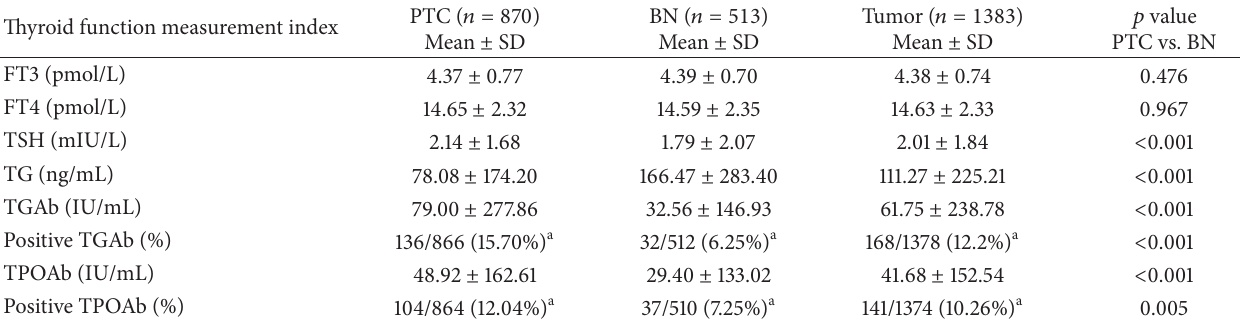
Table 3: Preoperative serum thyroid function measurement statuses in PTC and BN groups.